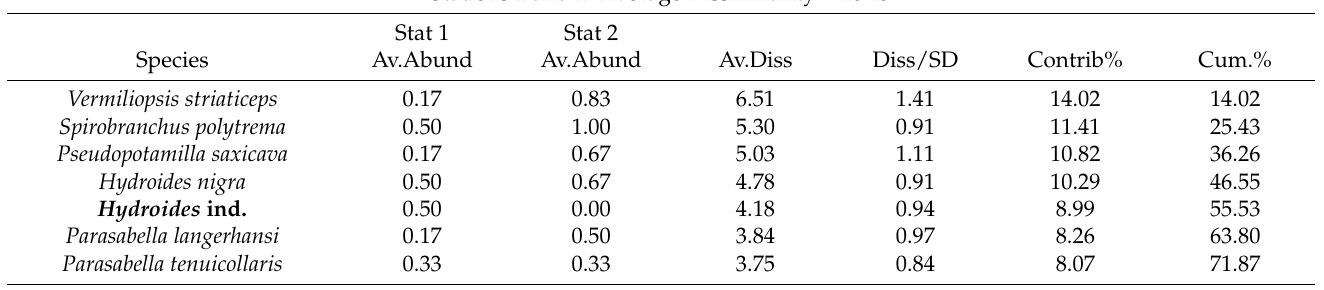
Table 4. SIMPER analysis based on species presence/absence, showing the species mostly contributing to faunal dissimilarity between stations (cut-off 70%). The species absent in one of the compared stations are given in bold. Av.Abund = average abundance, Av. Diss = average dissimilarity, Diss/SD = dissimilarity/standard deviation, Contib% = percentage contribution to dissimilarity, Cum% = cumulative percentage contribution to dissimilarity. Stations 1 and 2. Average Dissimilarity =